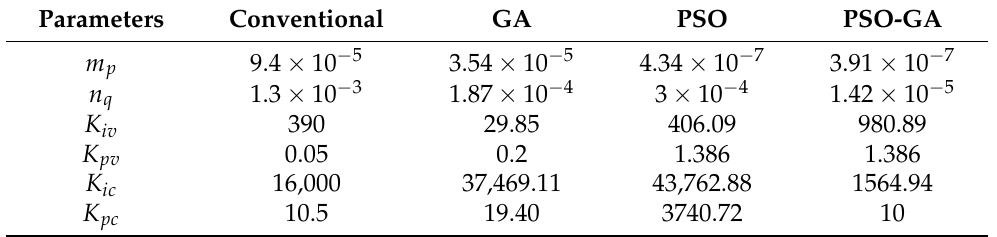
Table 4. The controllers’